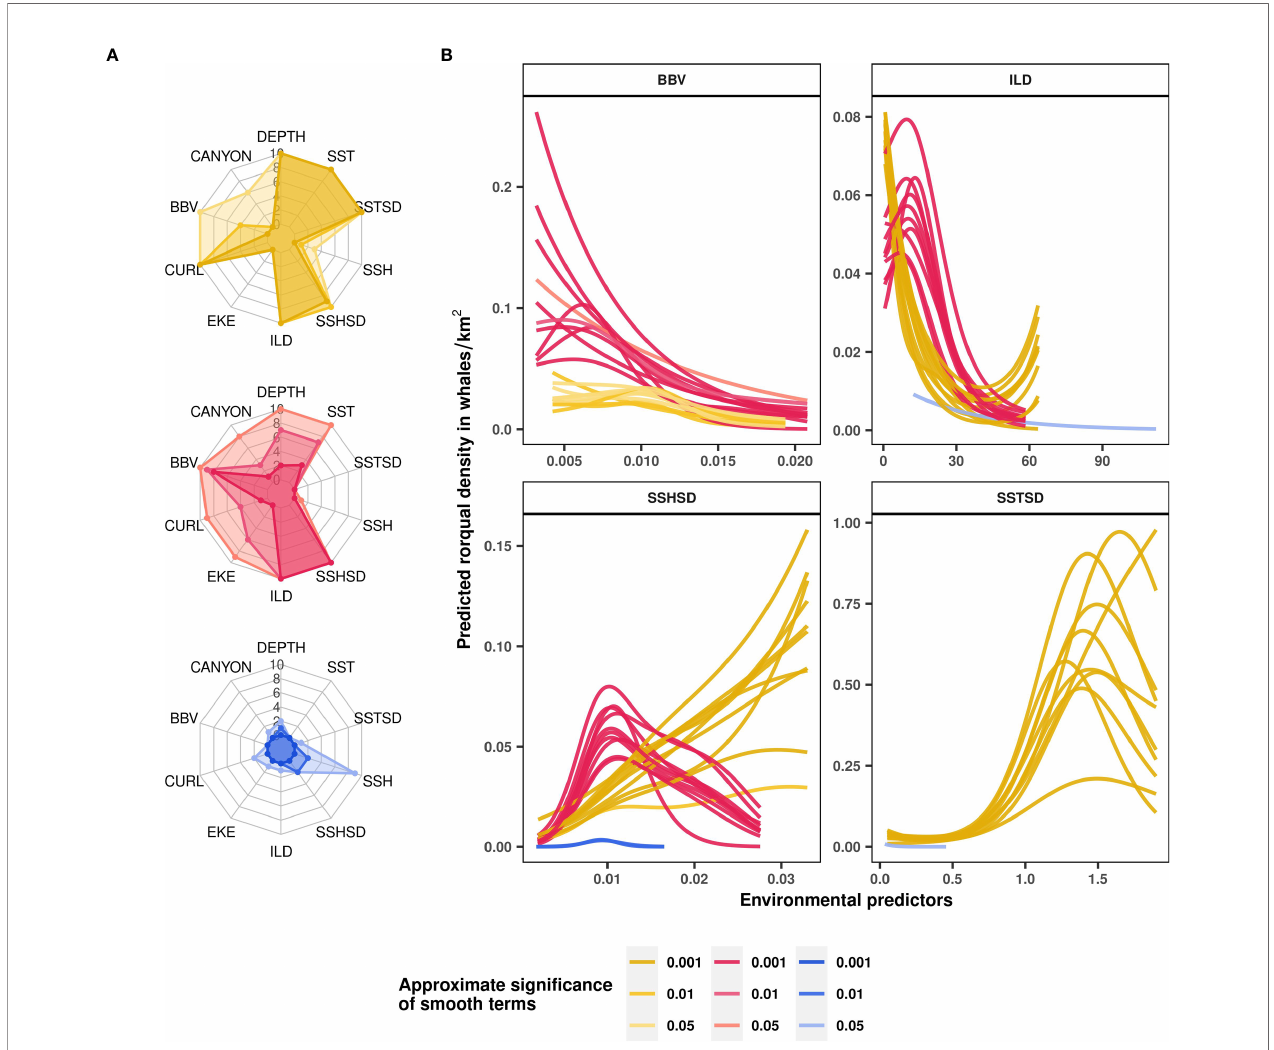
FIGURE 4 | Rorqual ecological relationships modelled over three seasons: April-July ( Mror-spring , in yellow), August-November ( Mror - summer , in pink) and December-March ( Mror-winter , in blue). Variable contributions to rorqual models illustrated as radar plots (A) are measured by the number of cross-validation folds in which the approximate smooth signi fi cance p-values were below 0.05, 0.01 or 0.001 (shown with increasingly dark color shades). Functional response curves (B) represent the effect of the smooth function of a selected set of predictor variables (BBV, ILD, SSHSD and SSTSD) upon the trend in rorqual density, with higher values indicating higher predicted densities. Solid lines represent the marginal effect of each variable relative to rorqual density per season and per cross-validation fold. Only the contributors with approximate smooth signi fi cance p-value < 0.05 are shown per model fold. Environmental variables: distance to canyons (CANYON in km), seabed depth (DEPTH in m), sea surface temperature (SST in °C) and its spatial standard deviation (SSTSD calculated over 0.3° squares), sea surface height (SSH in m) and its standard deviation (SSHSD calculated over 0.3° squares), eddy kinetic energy (EKE calculated from eastward and northward surface current velocities, kg·m 2 ·s − 2 ), wind stress curl (CURL in Newton.m -3 ), isothermal layer depth (ILD in m) and bulk buoyancy frequency (BBV in s -1